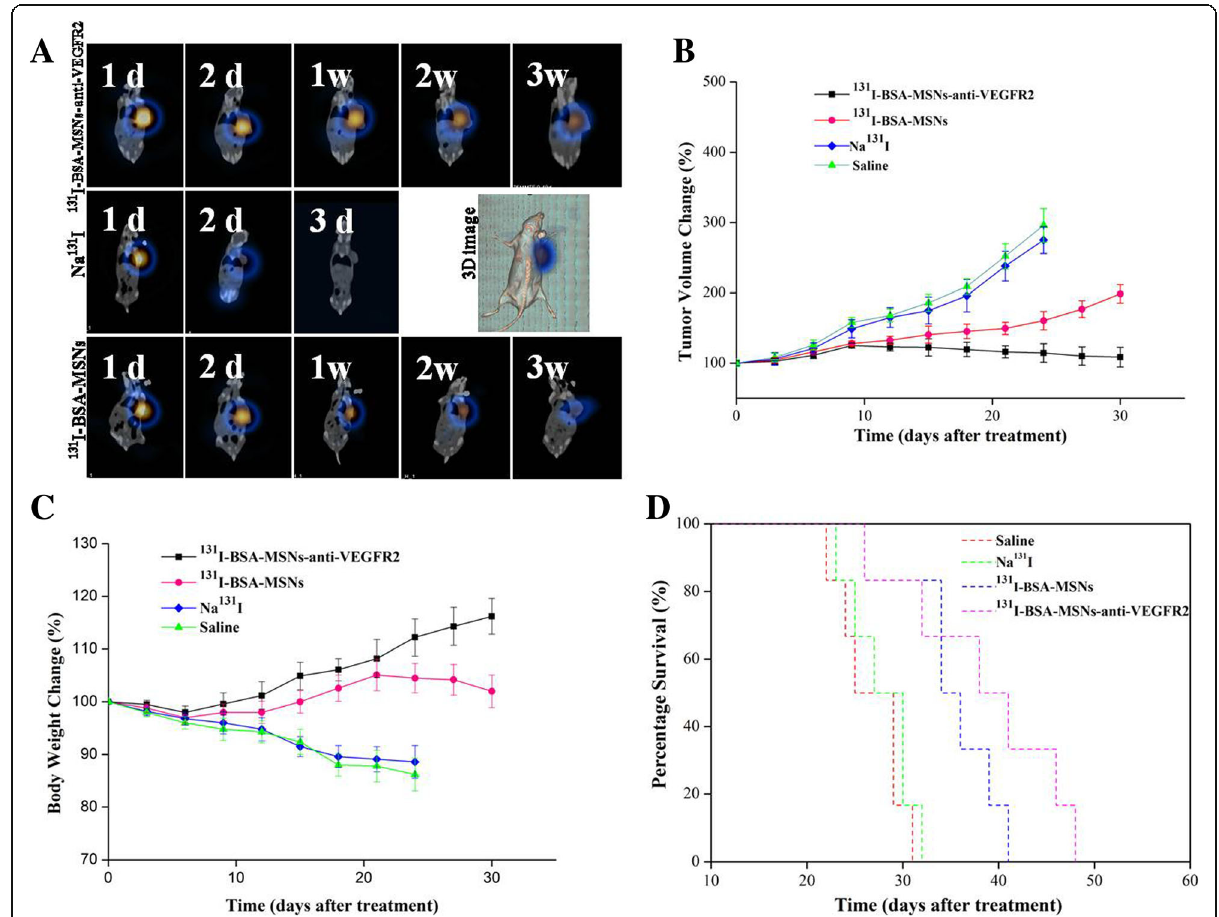
Fig. 4 In vivo imaging, in vivo 131 I therapy, and survival analysis. a SPECT/CT fused and three-dimension images of ATC tumor-bearing mice obtained at different time points after intratumoral injection with the respective drugs. The radioactive accumulation in the Na 131 I group was not seen at 3 days post-injection, but was obvious even at 3 weeks post-injection in the anti-VEGFR2 targeted group. Tumor volume ( b ), body weight ( c ) changes, and Kaplan – Meier survival curves ( d ) in the FRO ATC xenograft models ( n = 6/group). Tumor growth and body weight loss in the targeted group were significantly inhibited compared with those in the non-targeted, Na 131 I, or saline group, respectively. Data are presented as the mean ± SD of three groups and all were P < 0.05. Additionally, the median survival time in the targeted group (41 days) was significantly prolonged compared with that in the non-targeted (34 days) or Na 131 I (25 days) group (all P <